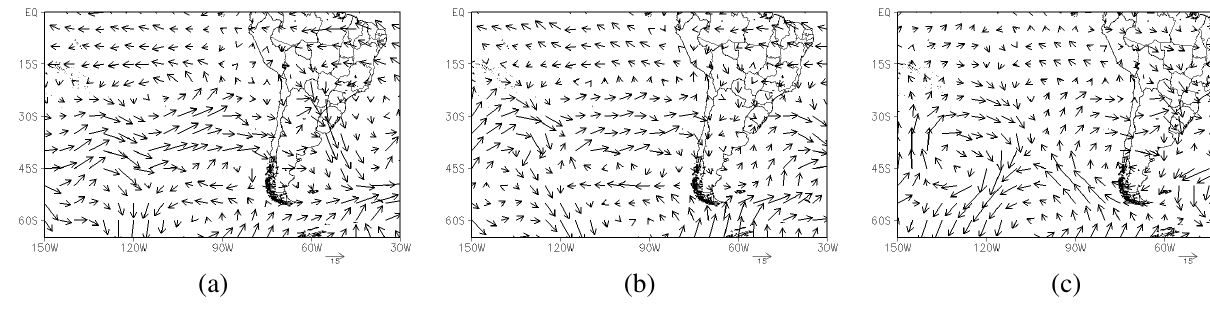
Fig. 11 – 850-hPa flow field for (a) 31 Aug, (b) 03 Sep, (c) 07 Sep 1999 at 00 UTC. Fig. 11. 850-hPa flow field for (a) 31 August, (b) 3, (c) 7 September 1999 at 00:00 UTC.